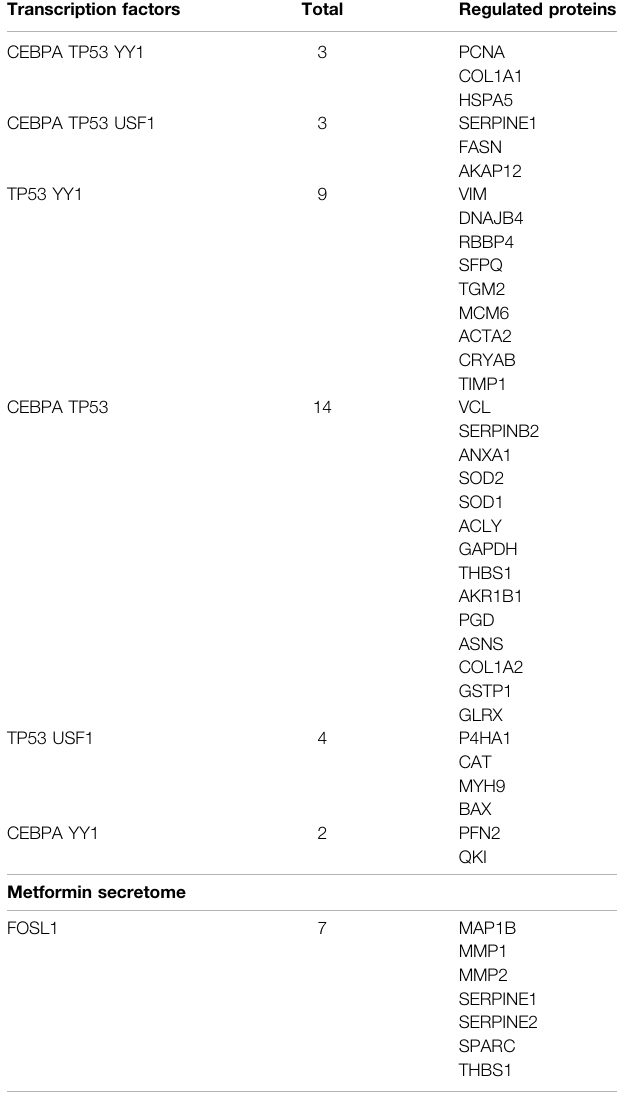
TABLE 3 | Proteins in the control datasets and the related upstream transcription factors. CTRL whole cell lysate. Transcription factors